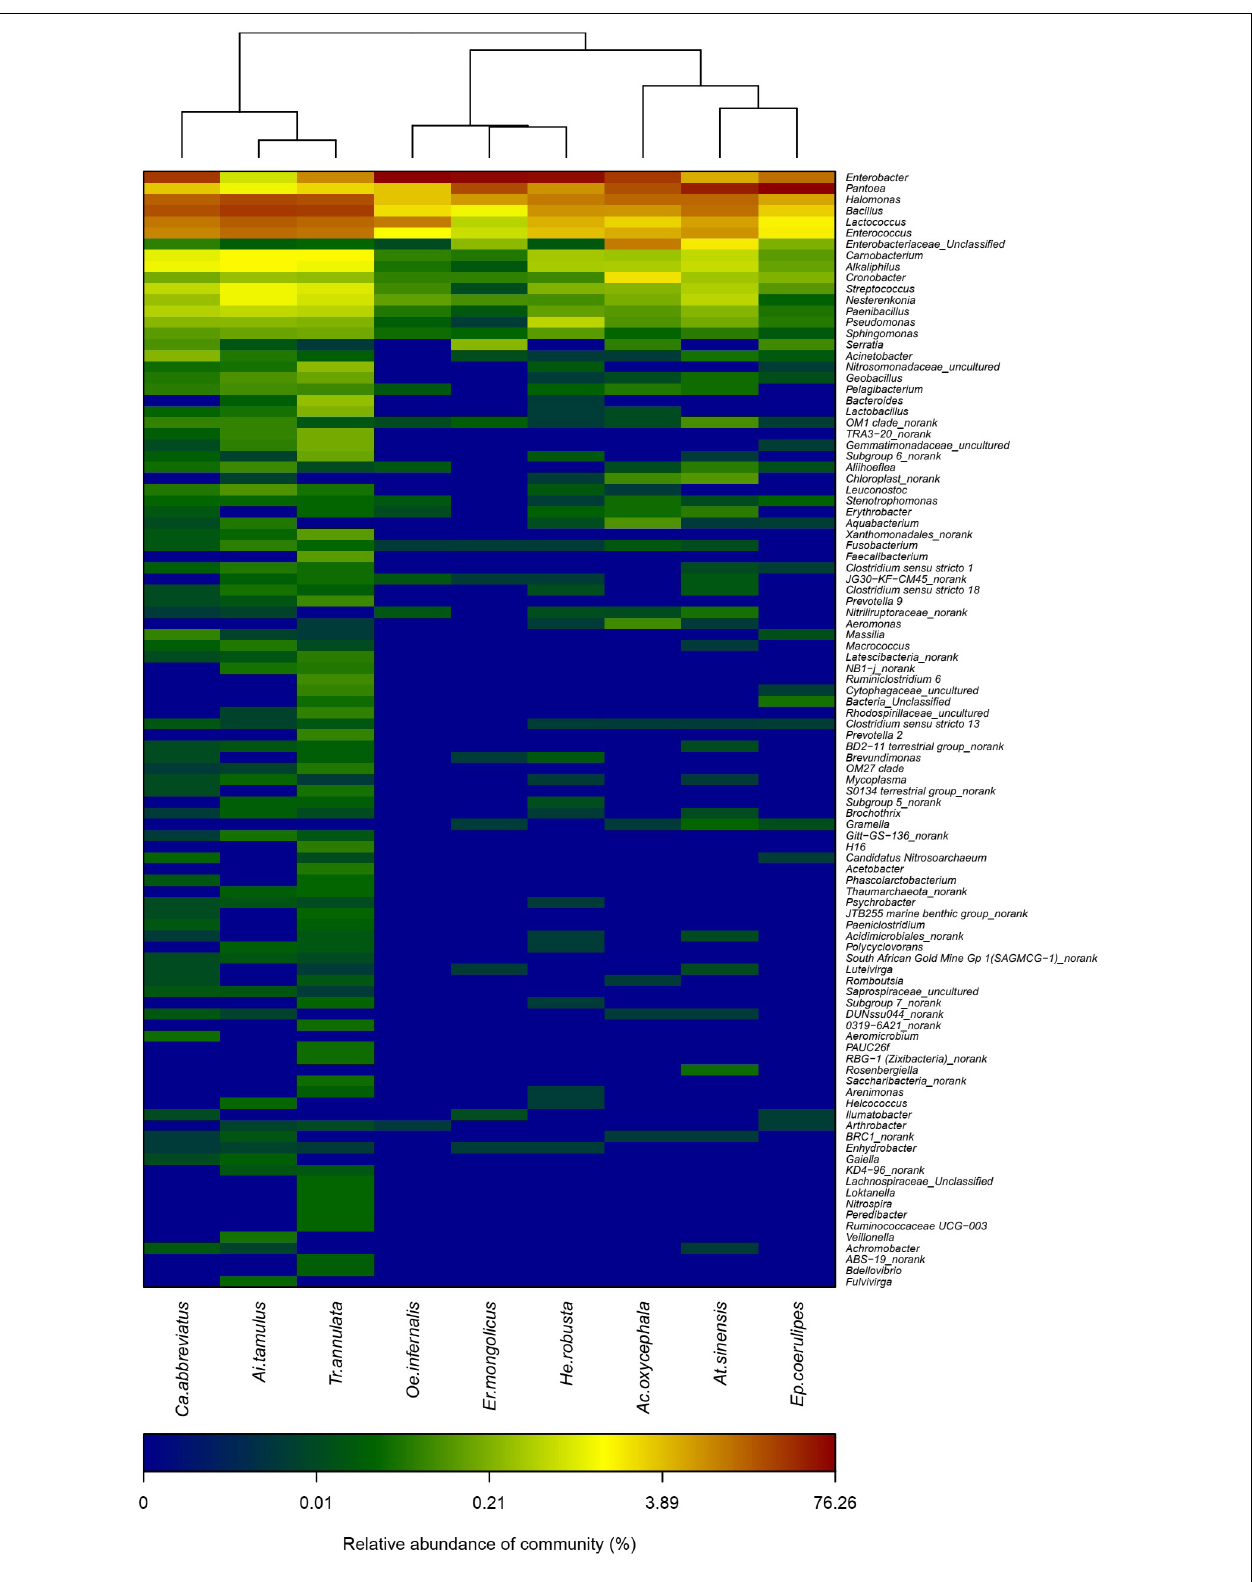
FIGURE 3 | Heatmap showing the relative abundance of OTUs and clustering across nine species.